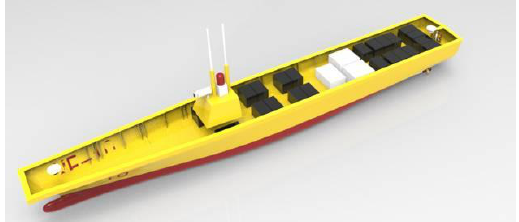
Figure 12. Conceptual design of the large-scale model arrangement. Figure 13. Sensors arrangement on the large-scale model.